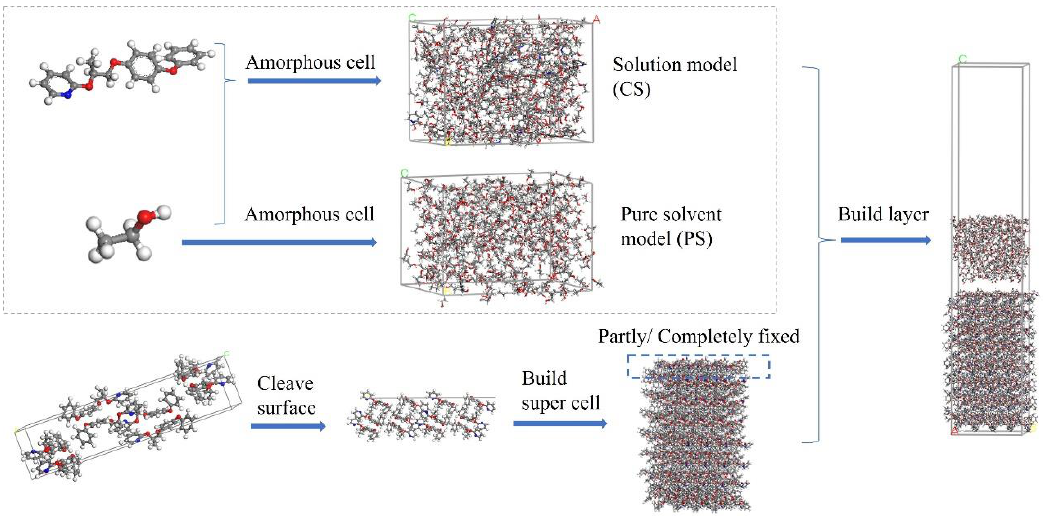
Figure 2. Schematic diagram of the construction of the model.